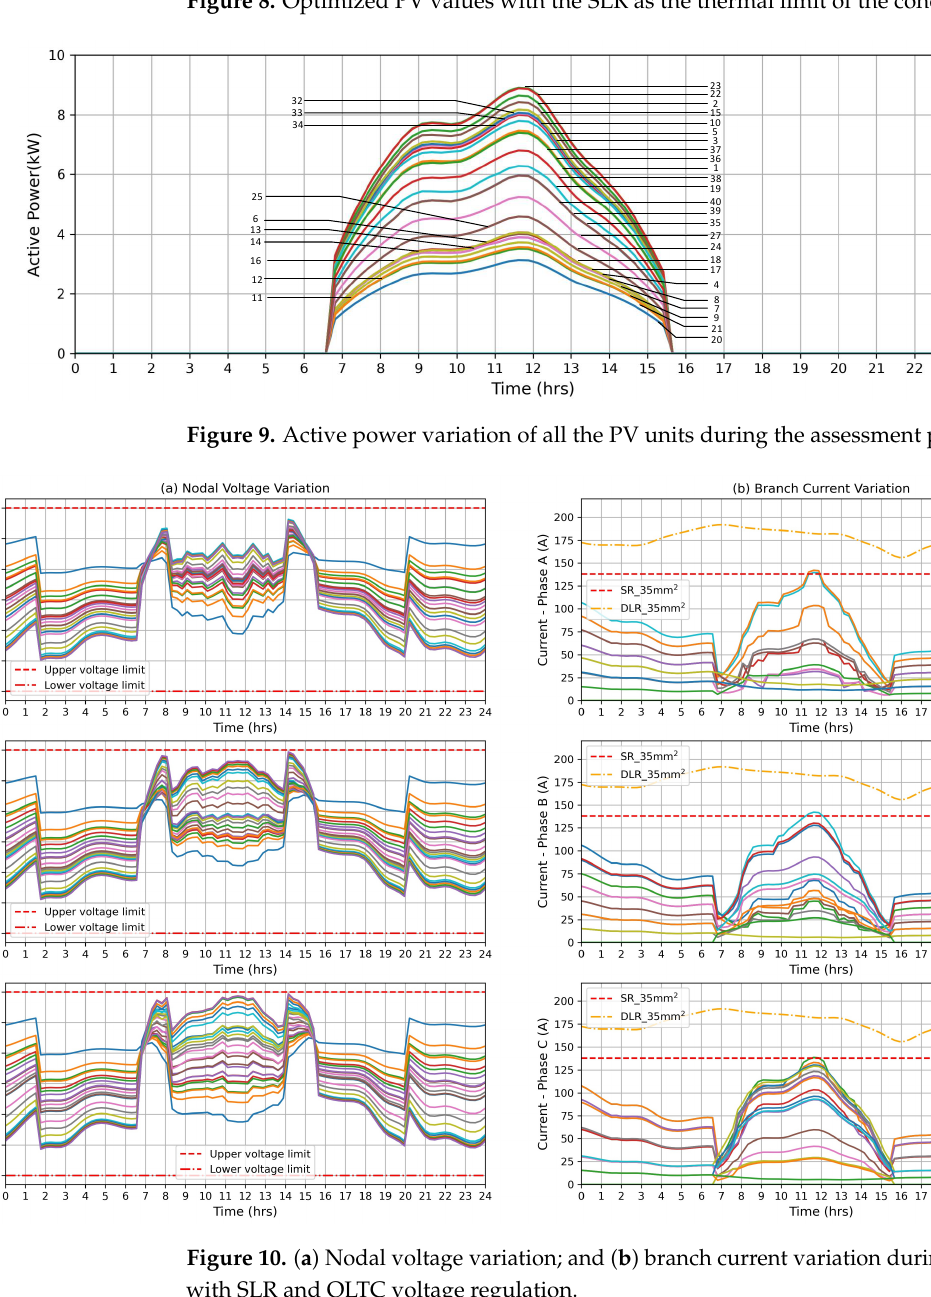
Figure 8. Optimized PV values with the SLR as the thermal limit of the conductors.